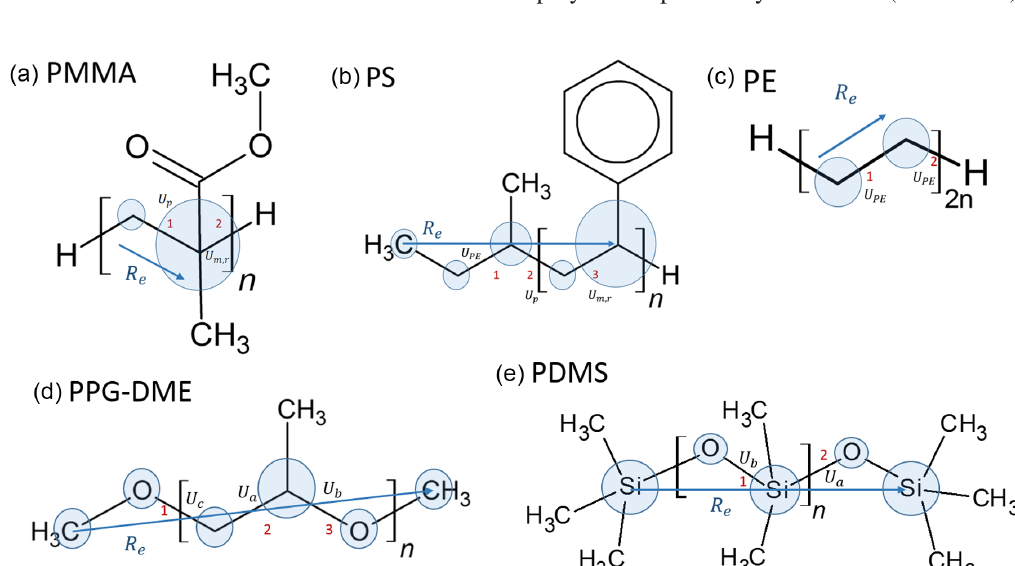
FIG. 6. Polymer structures used in the RIS calculations. The end-to-end vectors R are marked with blue arrows, red numbers label e bonds about which dihedral angles rotate, and blue circles show the atoms used to calculate the gyration tensor, with a spherical volume equal to the volume of all included atoms. The number of monomers is n . The volume of the backbone atom and its side groups is assumed to be localized on the backbone atom. For example, the blue circle centered on the Si atoms at the ends of PDMS represents the volume of Si and three CH 3 groups, while interior volumes comprise a Si and two CH 3